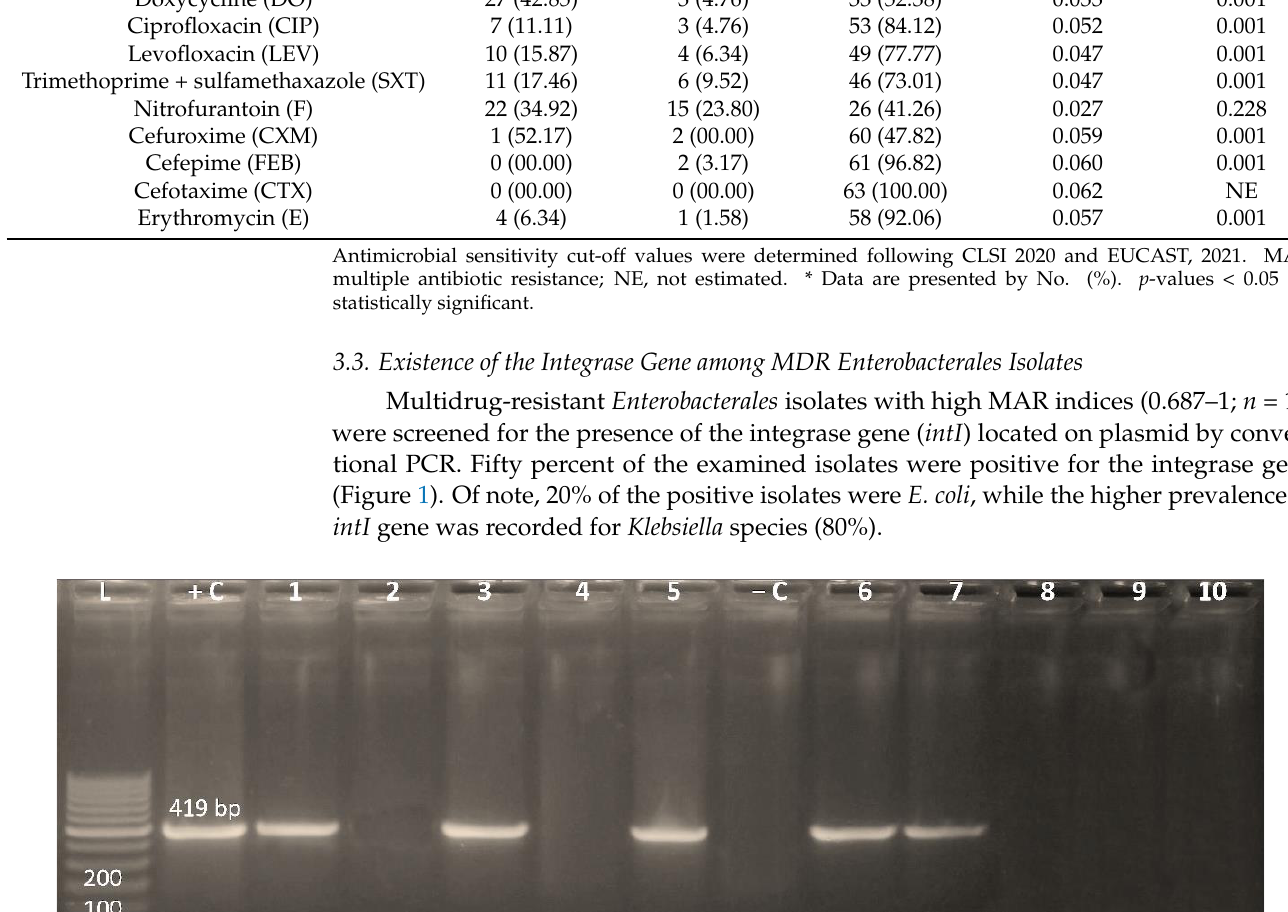
Figure 2. PCR-RFLP assay for differentiation of class 1 and class 2 integrons using Rsa I restriction enzyme. Lane L: 100-bp ladder; Lanes 2, 4 and 5 (334 bp and 157 bp) represent class II integrons; Lanes 1 and 3 (491 bp) represent class I integrons.